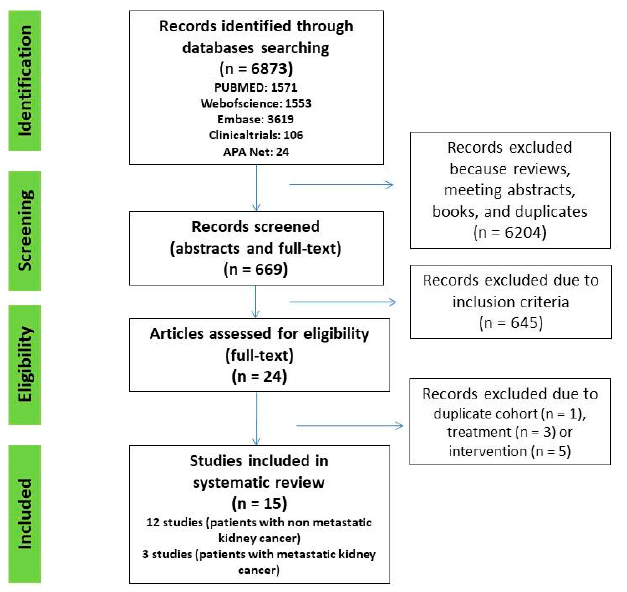
Figure 1. PRISMA flow chart of study selection process.